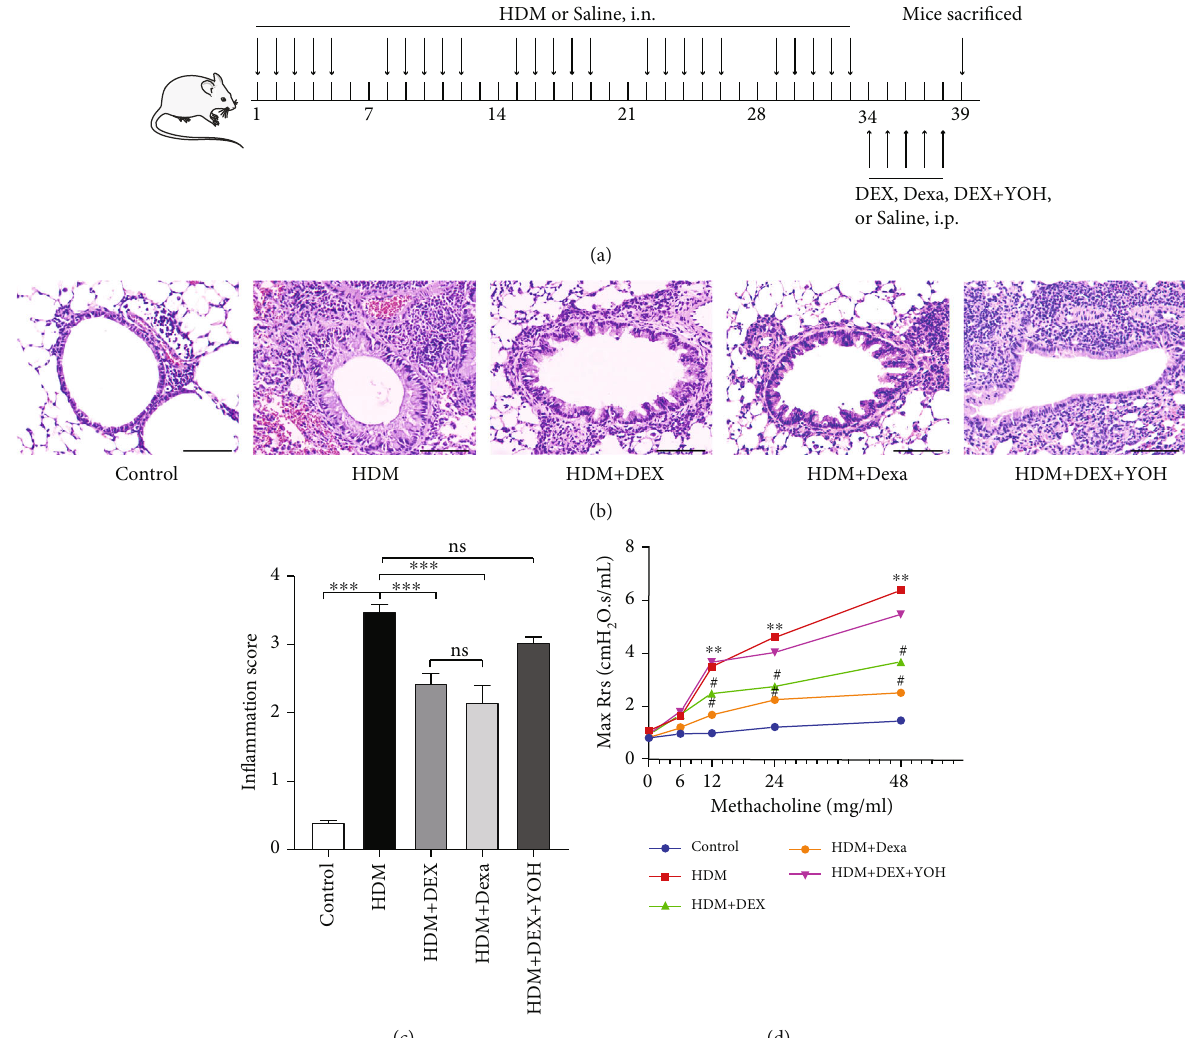
Figure 1: Administration of DEX attenuated in fl ammatory in fi ltration in lungs and AHR in HDM-challenged mice. (a) Schematic illustration of the protocol for chronic asthma model establishment. (b) Representative HE-stained images of lung tissue from each group ( scale bar = 100 μ m). (c) In fl ammation score estimated from the HE staining. (d) Changes of lung resistance in response to increasing doses of methacholine were evaluated 24 hours after the fi nal treatment in each group. Data were presented as mean ± SEM ( n = 5~ 8 animals). ∗ P < 0 : 05 , ∗∗ P < 0 : 01 , and ∗∗∗ P < 0 : 001 ; # P < 0 : 05 , compared with the HDM